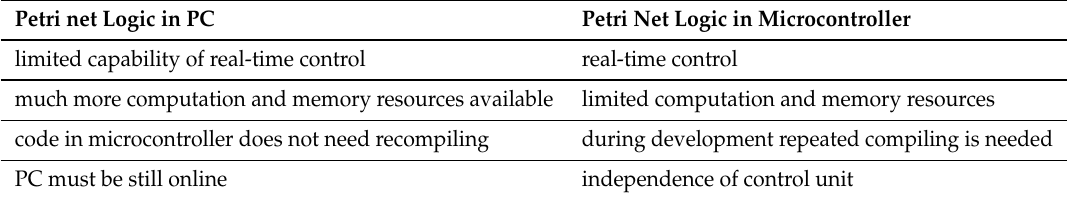
Table 1. Comparison of two concepts of system control using Petri nets